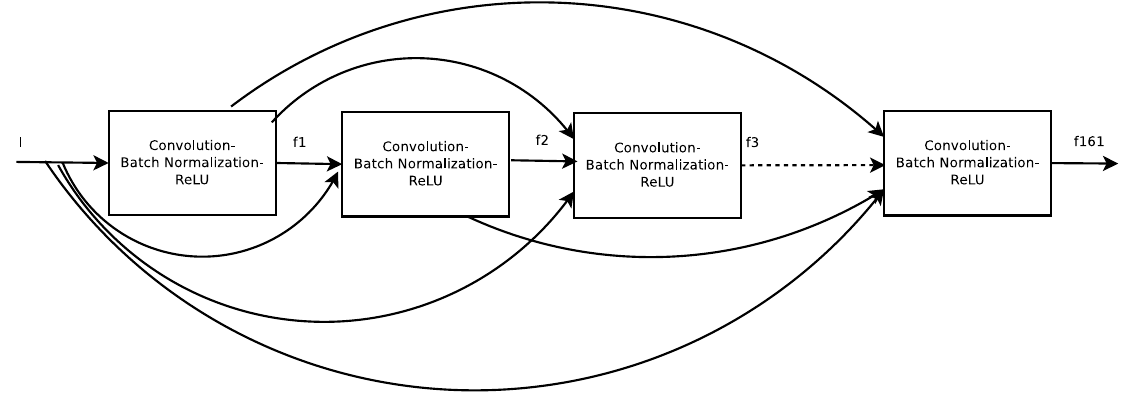
Figure 3. Architecture of